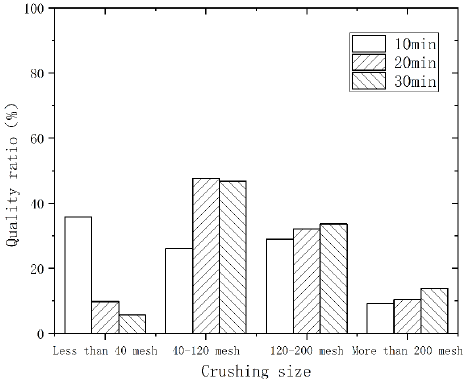
Figure 4. Particle size distribution for different times at 5000 r/min.